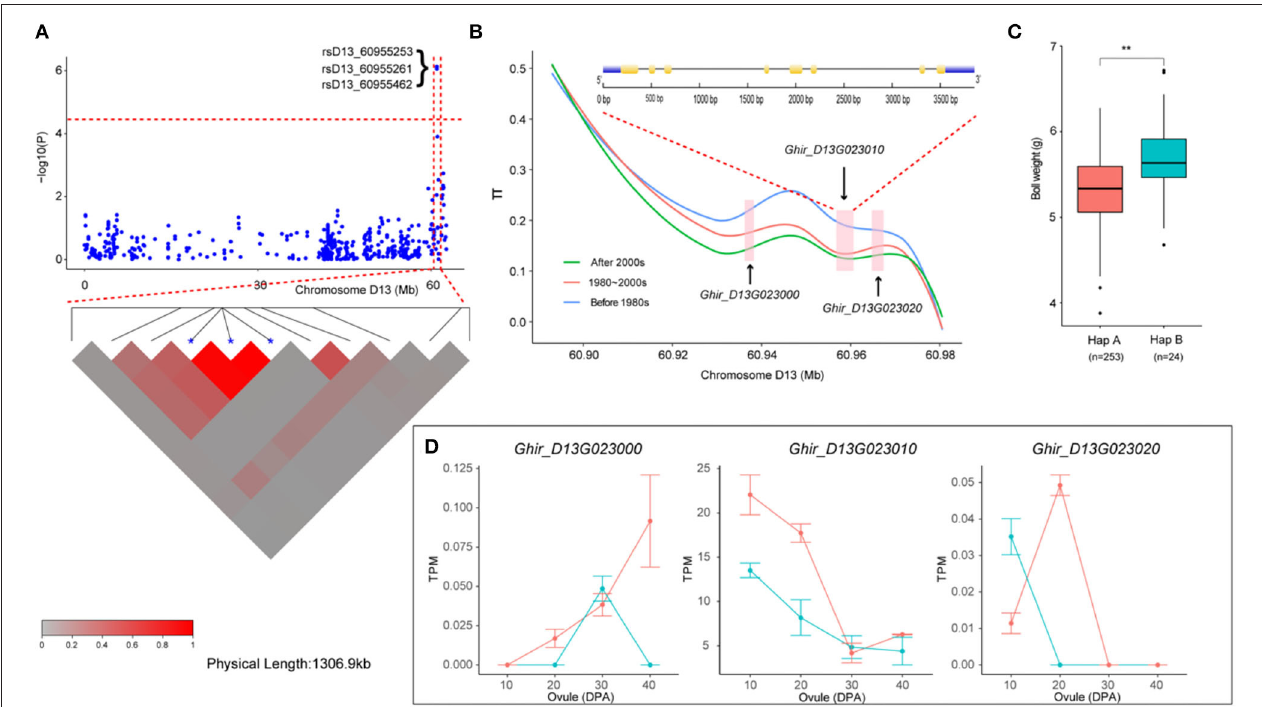
FIGURE 5 | Variation analysis of the boll weight-related gene Ghir_D13G023010 on candidate region. (A) Local Manhattan plots for BW-related genes on chromosome D13 and LD heatmap for the candidate region within the peak region of rsD13_60955253, rsD13_60955261, and rsD13_60955462. (B) Genetic diversity across the three populations and exon–intron structure of Ghir_D13G023010 . (C) Box plots for BW of the two haplotypes mentioned above (** P < 0.01, * P < 0.05). (D) Expression abundance analysis of Ghir_D13G023010 between “TM-1” (green) and “CRI12” (red) during ovule developmental stages (0, 10, 20, 30, and 40 DPA) by